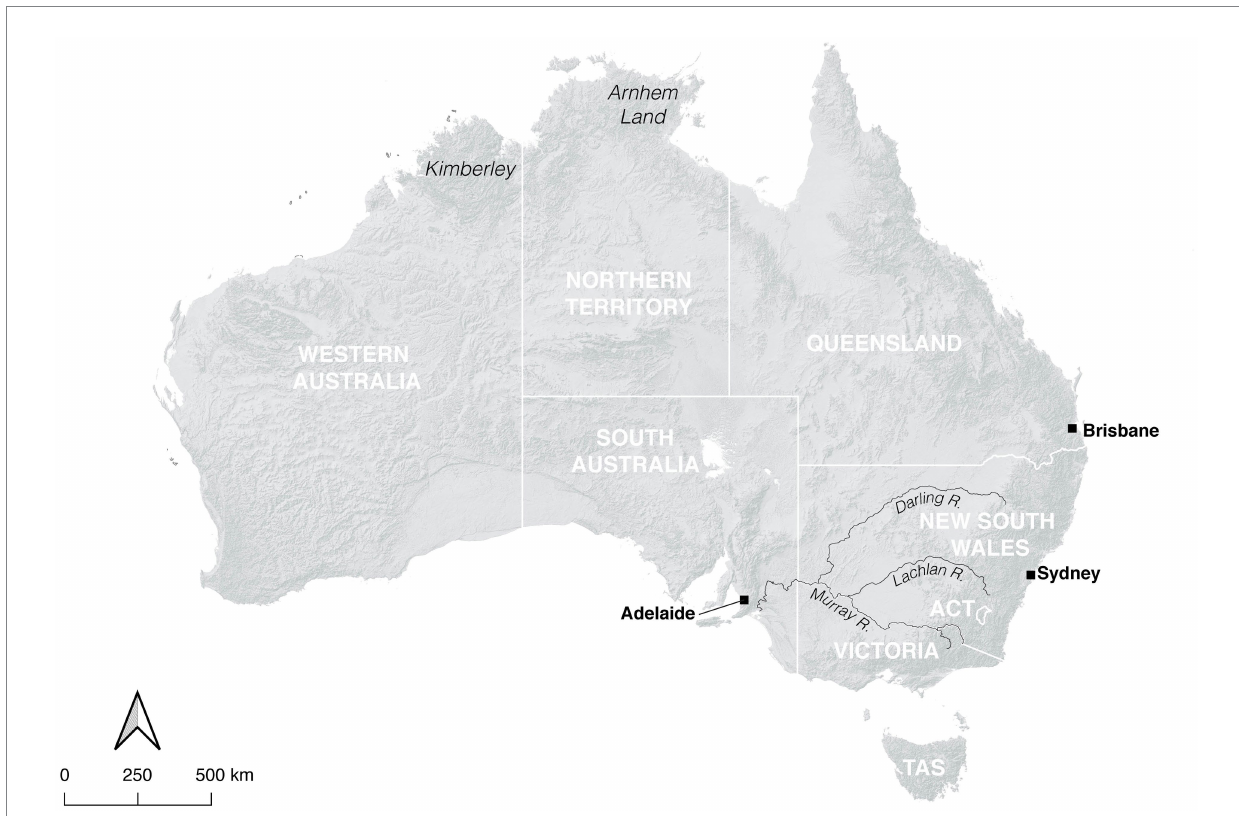
FIGURE 2 Map of Australia. The major rivers of the southern extent of the Murray-Darling basin are shown. Base map: Kim